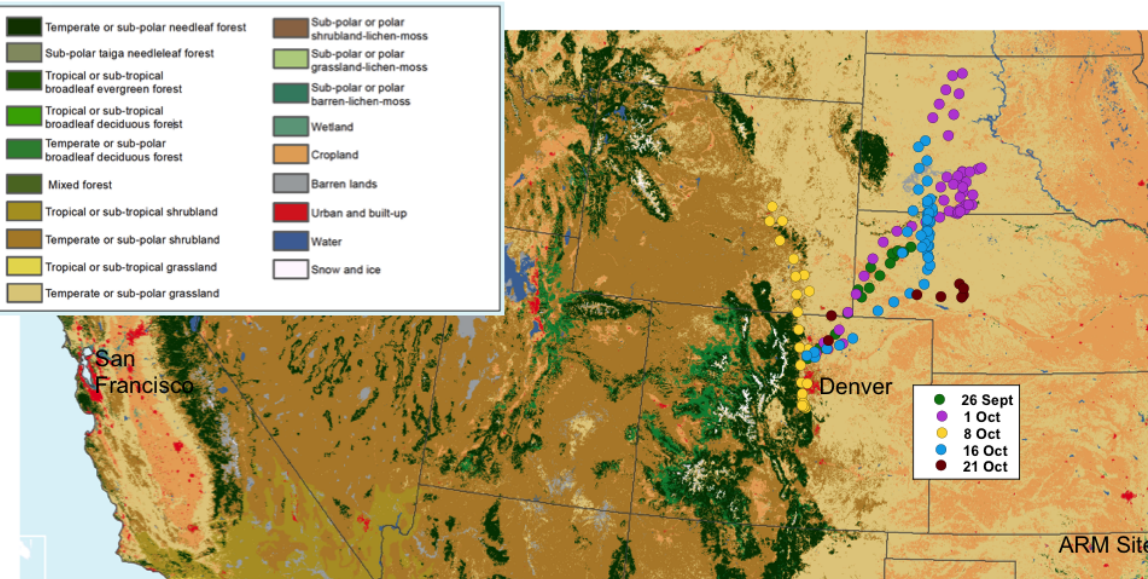
Figure 2. Location of clear-air sampling on five flights during the IDEAS-2013 field program. Each colored dot on the right shows the location of 200s averaged WIBS-4A data for the dates shown in 2013. Location where aerosol extinction data shown in Fig. 1 were taken (Oklahoma ARM site) is noted at lower right. Map colors show the 2010 North American Land Cover at 250m spatial resolution for sampling and upstream regions. Produced by Natural Resources Canada/the Canada Centre for Mapping and Earth Observation (NRCan/CCMEO), United States Geological Survey (USGS); Insituto Nacional de Estadística y Geografía (INEGI), Comisión Nacional para el Conocimiento y Uso de la Biodiversidad (CONABIO), and Comisión Nacional Forestal